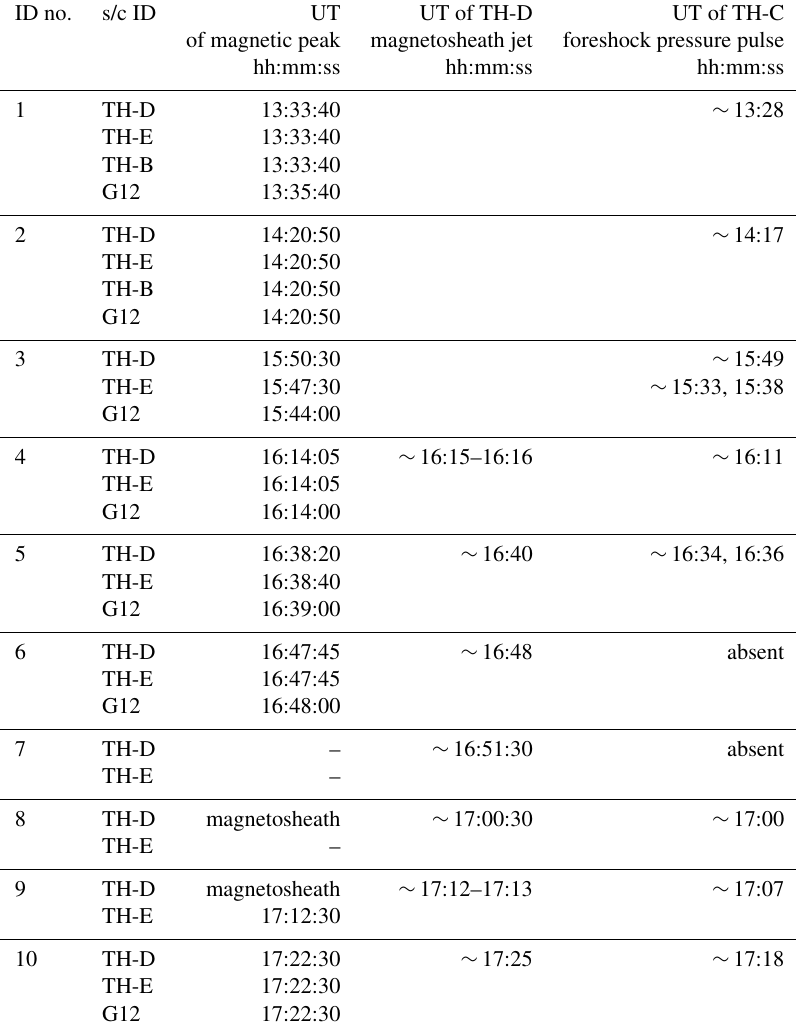
Table 2. Timing of magnetic field enhancements and plasma pulses from THEMIS and GOES12. ID no. s/c ID UT UT of TH-D UT of TH-C of magnetic peak magnetosheath jet foreshock pressure